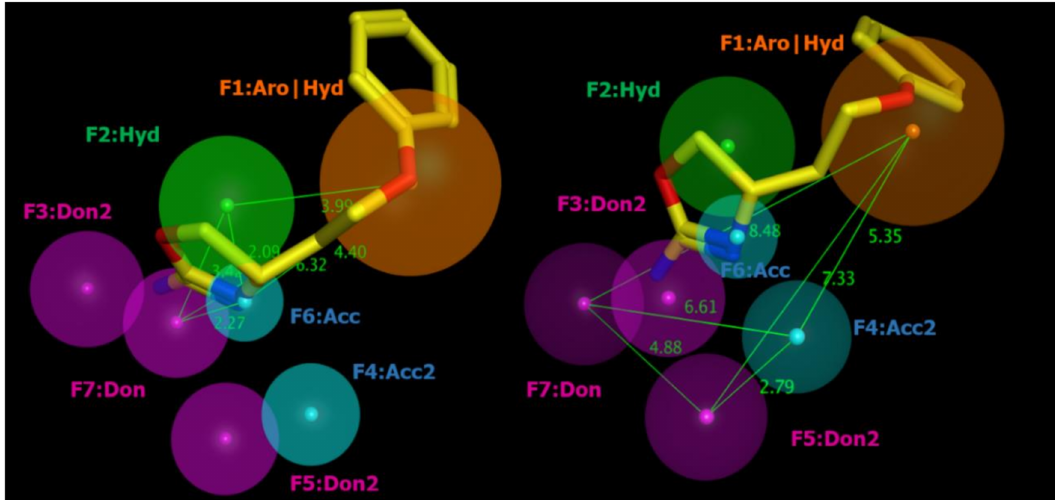
Figure 5. Pharmacophore features shared by most of the oxazolines acting as h TAAR1 agonists (Table S1). The most potent derivative 20b is mapped onto the corresponding pharmacophore model (PM) features and is depicted by sticks (colors as in Figure 4). Distances between the main groups are shown as green lines and labelled